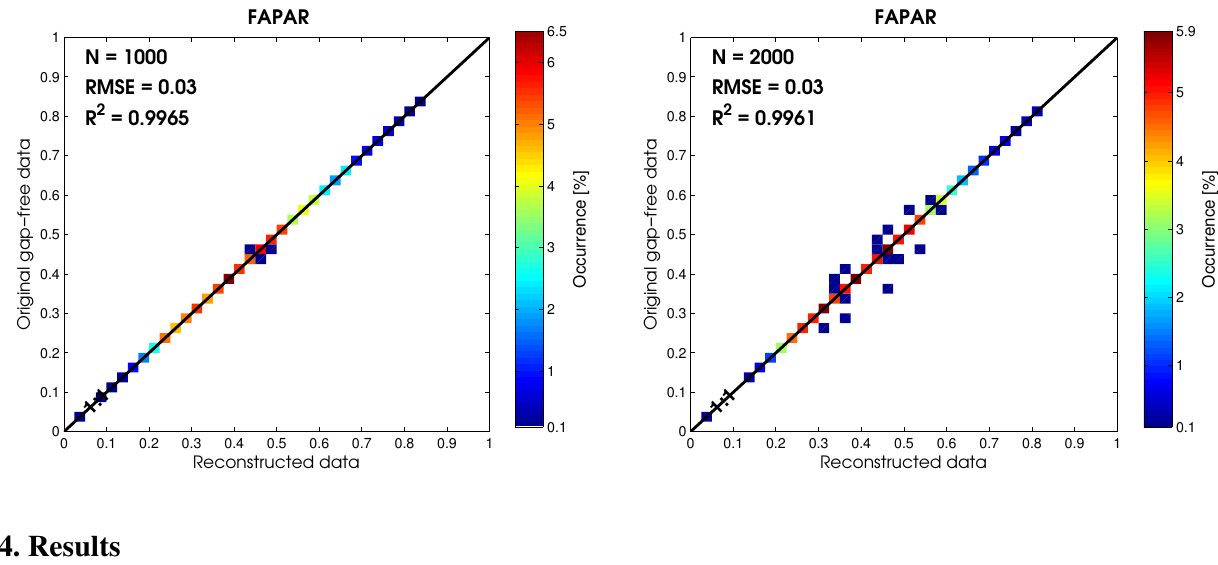
Figure 5. Impact of the gap filling process on the FAPAR dataset over a test region located in the western part of France. Scatterplot of observed and reconstructed FAPAR fields from MERIS during 2006 with one gap (left panel) and with two consecutive gaps (right panel). The underlying idea of this test is to use an almost cloud-free FAPAR time series